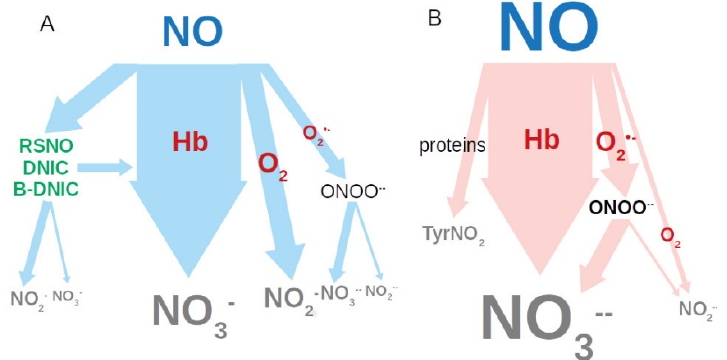
Figure 5. Nitric oxide metabolizing pathways: ( A ) normal; ( B ) with oxidative stress. RSNO: nitrosyl thiols; DNIC: iron (II) thiol groups with NO; B-DNIC: binuclear DNIC.